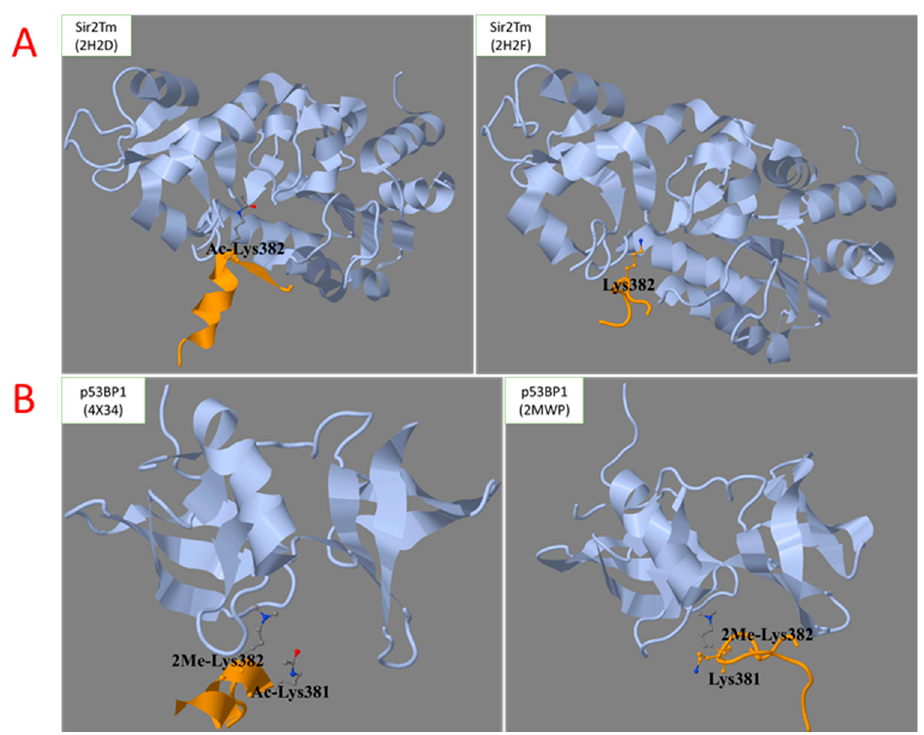
Figure 4. The role of post-translational modifications of p53 in the stabilization of secondary structures of the intrinsically disordered C-terminal region upon the heterologous complex formation with NAD + -dependent protein deacetylase Sir2Tm ( A ) and TP53-binding protein 1, p53BP1 ( B ). The Uniprot names of the p53 partner proteins (shown in grey) and pdb identifiers of the structures of their complexes with p53 C-terminal region (in yellow) are indicated in the upper-left corner of each panel.